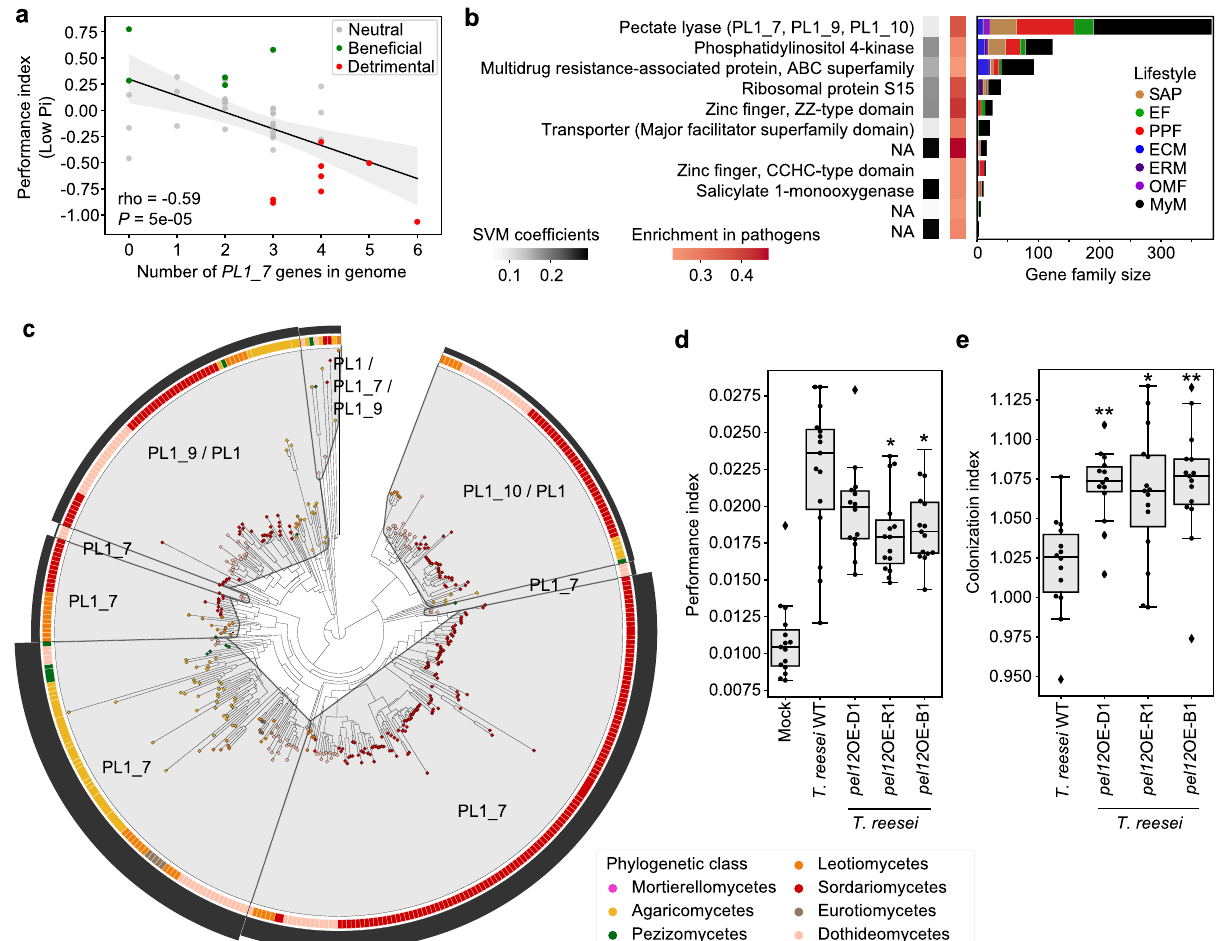
Fig. 6 Genomic content in polysaccharide lyase PL1_7 links colonization aggressiveness to plant health. a Spearman ’ s rank correlation between the number of genes encoding secreted PL1_7 in fungal genomes and the plant performance index at low Pi in recolonization experiments. b Minimal set of 11 gene families discriminating detrimental from non-detrimental fungi at low Pi (SVM-RFE R 2 = 0.88). The fi rst heatmap on the left shows the SVM coef fi cients, re fl ecting the contribution of each orthogroup to the separation of the two groups, whereas the heatmap on the right shows the enrichment of these gene families in fungi identi fi ed as detrimental in recolonization experiments at low Pi. Gene family sizes and representation in the different lifestyles are shown on the barplots in the context of the whole fungal dataset ( n = 120). NA: no functional annotation. c Protein family tree of the polysaccharide lyase orthogroup identi fi ed as essential for segregating detrimental from non-detrimental fungi in our SVM-RFE classi fi cation model. The tree was reconciled with fungal phylogeny and clustered into minimum instability groups by MIPhy 56 . Each group is labeled with its CAZyme annotation. The outer circle (black barplot) depicts the relative instabilities of these groups, suggesting two rapidly evolving PL1_7 groups in Sordariomycetes and Agaricomycetes. d Plant performance indices resulting from plant recolonization experiments at low Pi (three independent biological replicates), conducted with Trichoderma reesei QM9414 (WT) and three independent heterologous mutant lines (D1, R1, B1) overexpressing pel12 from Clonostachys rosea (PL1_7 family, 57 ). Asterisks indicate signi fi cant difference to T. reesei WT, according to ANOVA ( P = 1.45e − 12) and a two-sided TukeyHSD test (WT vs. D1: adjusted P = 0.28; WT vs. B1: adjusted P = 3.75e − 2; WT vs. R1: adjusted P = 1.19e − 2). e Fungal colonization measured by qPCR in colonized roots at low Pi, conducted with T. reesei WT and three pel12 overexpression mutant lines. Asterisks indicate signi fi cant difference to T. reesei WT, according to Kruskal – Wallis ( P = 6.25e − 4) and a two-sided Dunn test (WT vs. D1: adjusted P = 2.4e − 3; WT vs. B1: adjusted P = 1.6e − 3; WT vs. R1: adjusted P = 1.5e − 2). For both d and e , three independent biological replicates were performed resulting in n = 15 data points per condition. Boxes are delimited by fi rst and third quartiles, central bars show median values, whiskers extend to show the rest of the distribution, but without covering outlier data points (further than 1.5 interquartile range from the quartiles, and marked by lozenges). Asterisks highlight the results of post hoc tests: **adjusted P < 0.01, *adjusted P <